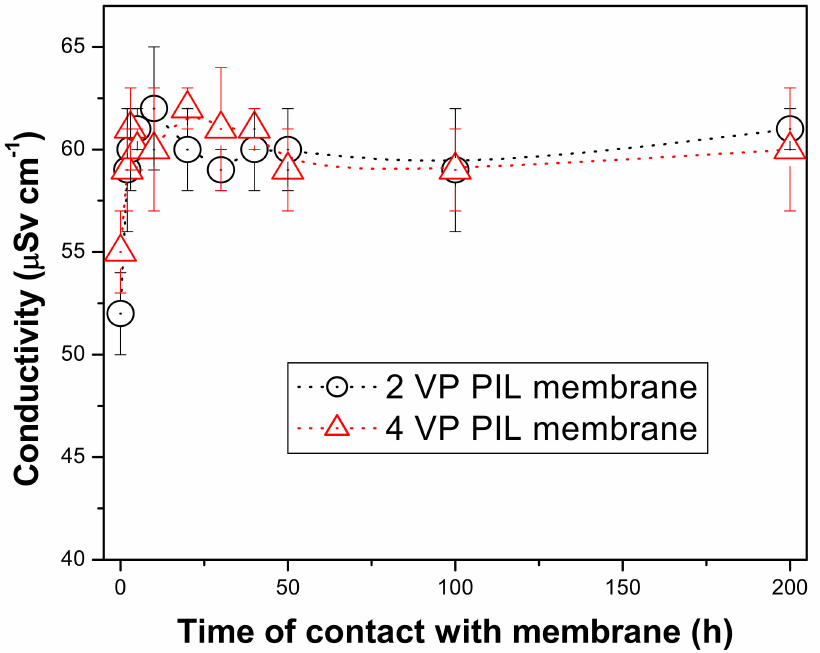
Figure 12. Monitoring of the conductivity of the supernatant solutions where PIL augmented membranes were immersed at various time